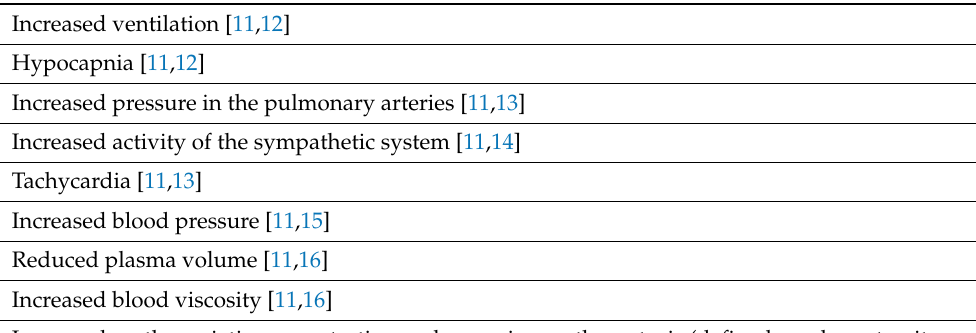
Table 1. Physiological changes in high-altitude conditions.